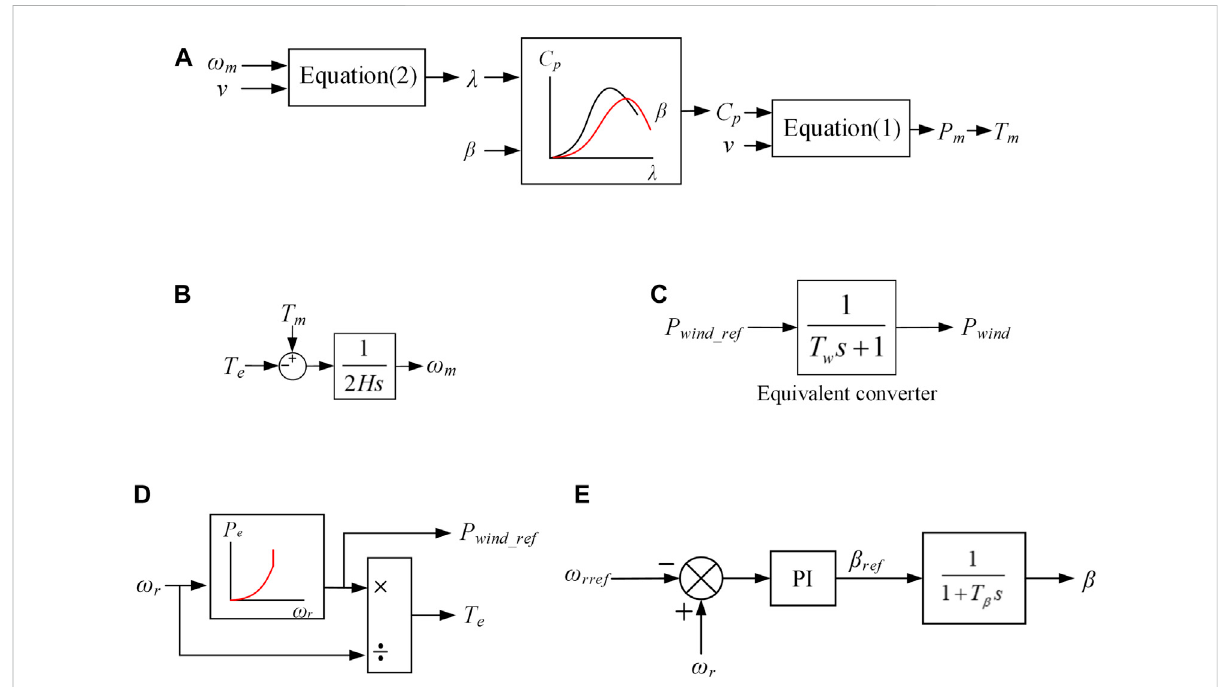
FIGURE 3 (A) Structure diagram of the simpli fi ed model which is the simpli fi ed aerodynamic part of wind turbine. (B) Simpli fi ed part of the permanent magnet synchronous motor. (C) Simpli fi ed converter model. (D) Simpli fi ed power control module. (E) Simpli fi ed pitch angle control model. The aforementioned models are simpli fi ed by the equivalent transfer